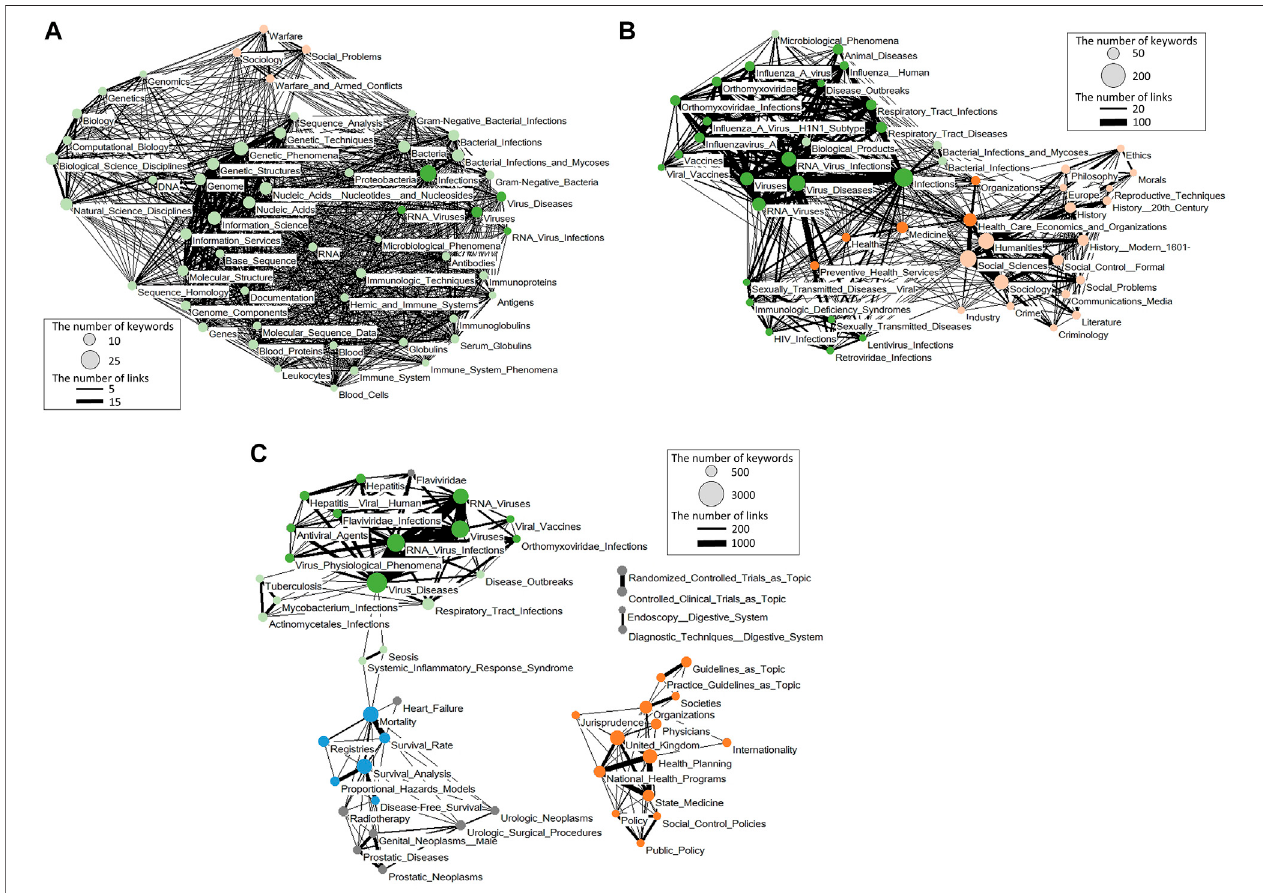
FIGURE2| NetworksofTop50uniquekeywordsusedbynewcomerstocoronavirusresearch. (A) Thenetworksoftop50uniquekeywordsin1998 – 2002,which wereusedbythoseresearcherswhoconverted tocoronavirusresearchin2003 – 2006. (B) Thenetworksoftop50uniquekeywordsin2008 – 2012,whichwereusedby those who started coronavirus research in 2013 – 2016. (C) The networks of top 50 unique keywords in 2015 – 2019, which were used by those who converted to coronavirus research in 2020. The node colors represent the fi elds related to the keywords (green: virus and its infection; light green: molecular biology, microbiology, and immunology; orange: health care and policy; light orange: humanity and social issues; blue: epidemiology; gray: other issues). The threshold for making edges was set at 10% of the number of keywords (selecting smaller sized nodes) linked by the edges.